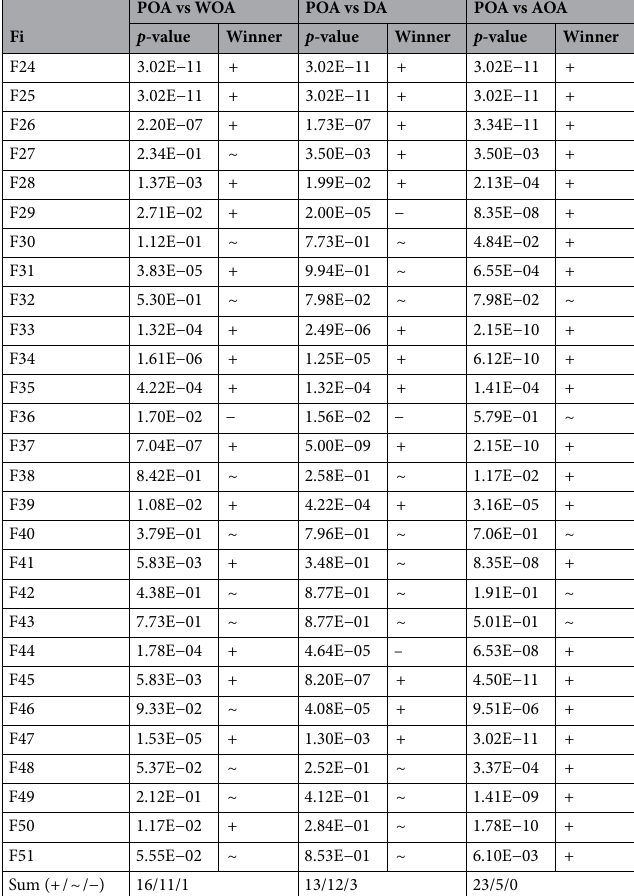
Table 9. Results of Wilcoxon sign-rank test for CEC 2017 problems with α = 0.05.